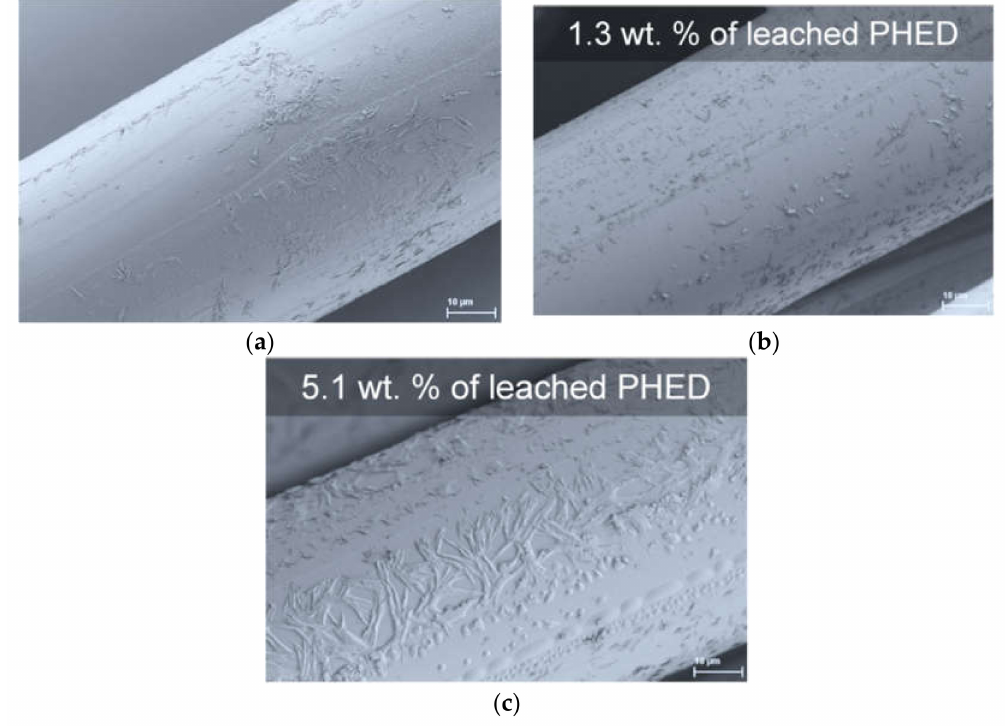
Figure 10. Representative SEM images of the surface morphology of the leached ( a ) PA6, ( b ) PA6/10PHED, and ( c ) PA6/15PHED